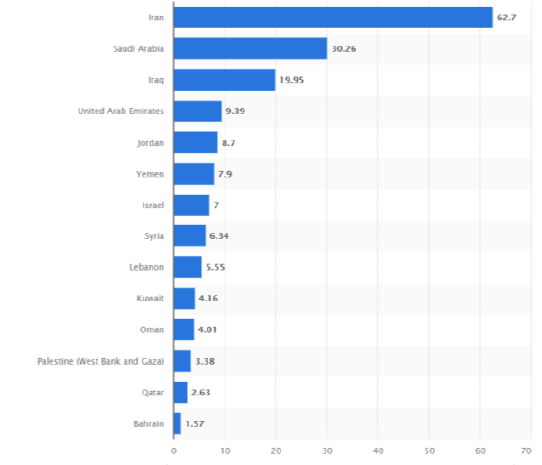
Figure 1: Number of internet users in the Middle East as of June 2017, by country (in millions) (Source: https://www.statista.com/statistics/603061/number-of-internet-users-in- middle-east-countries/) The number of worldwide internet users, sorted by region. As of January 2019, East Asia accounted for 1 billion internet users, followed by Southern Asia with 803 million internet users (Fig.